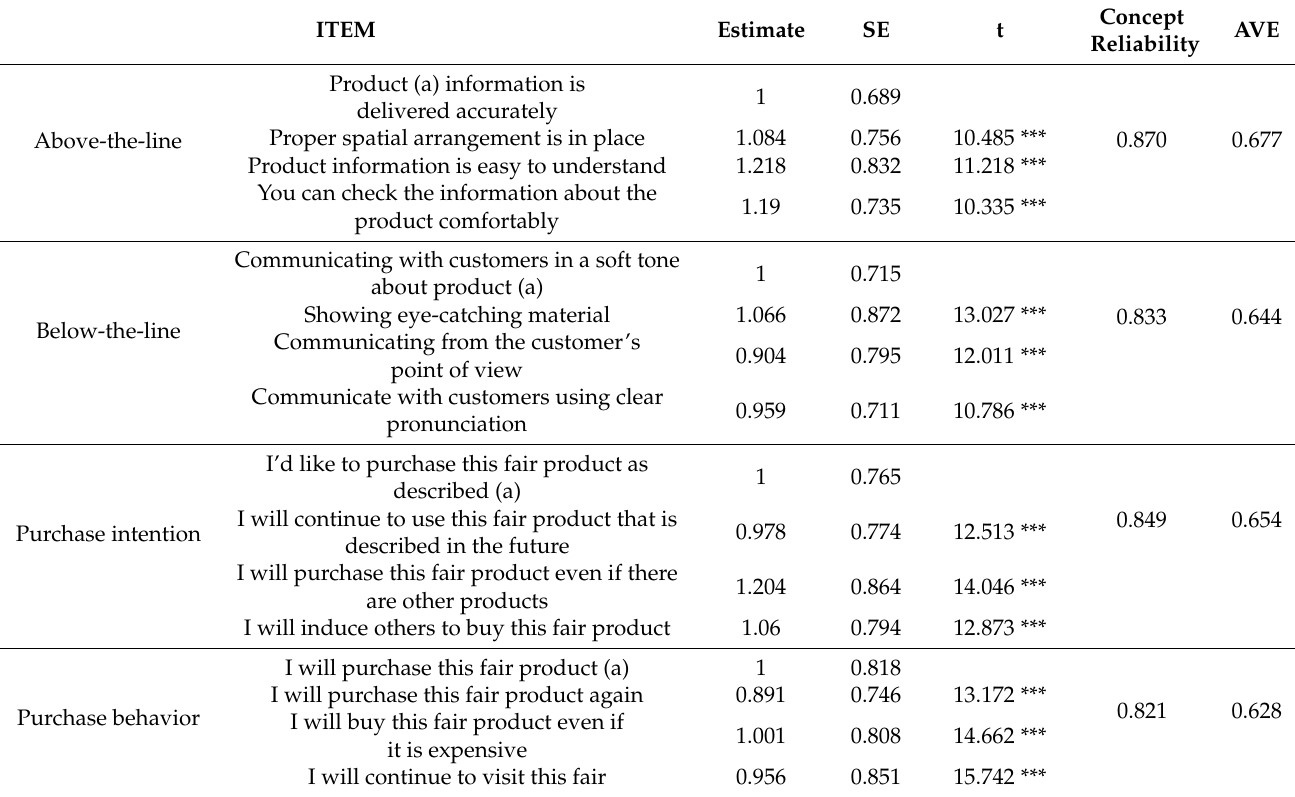
Table 2. Result of confirmatory factor